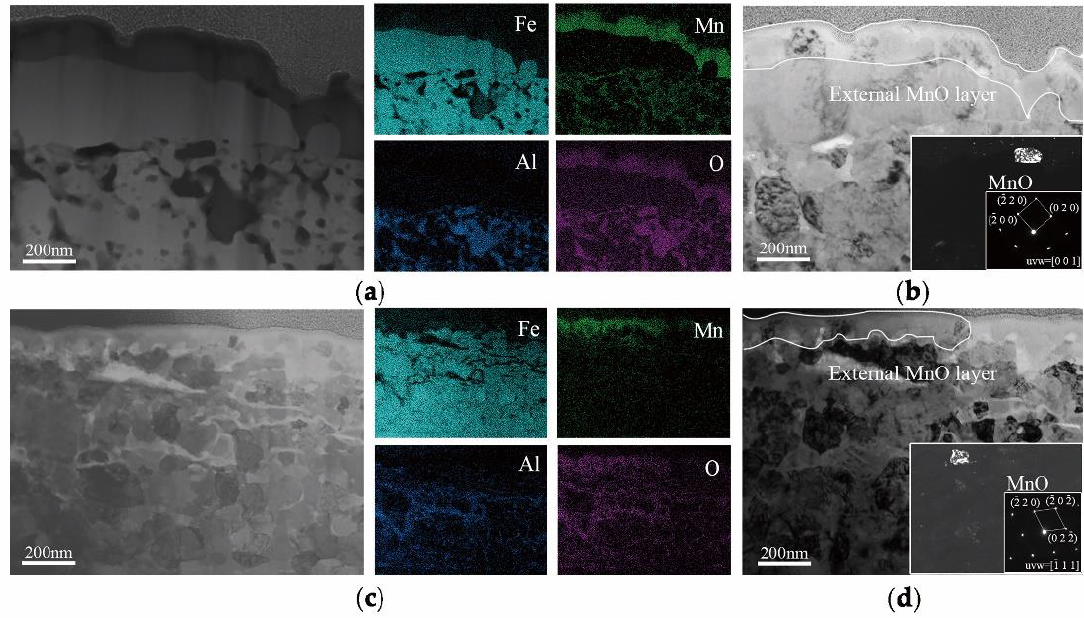
Figure 9. Cross-sectional TEM micrographs and EDS elemental distribution maps of the annealed surface of 3Mn + 10 ◦ C ( a , b ) and 3Mn − 30 ◦ C ( c , d ) selective oxidation samples.